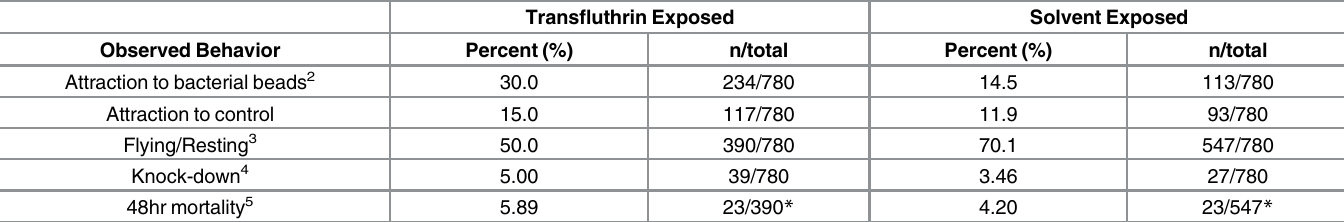
Table 2. Effects of transfluthrin (n = 780) or solvent (n = 780) exposure on gravid Ae. aegypti 1 attraction to experimental oviposition